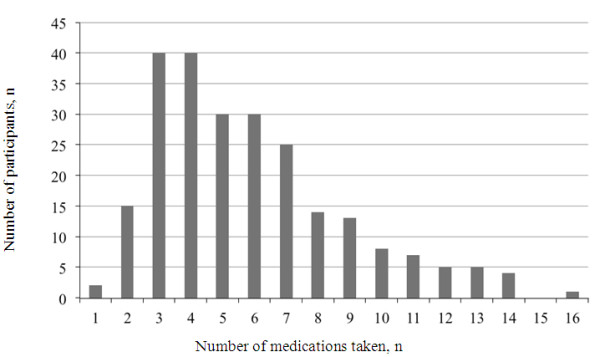
Treatment Patterns: Total Number of Psychotropic Medications1 Taken During the Study.1 Psychotropic medications included are: antipsychotics, antidepressants, benzodiazepines, mood stabilizers (olanzapine, lithium, valporate, and carbemazepine), anticonvulsants (lamotrigine), anticholinergics, anxiolytics, and hypnotics.